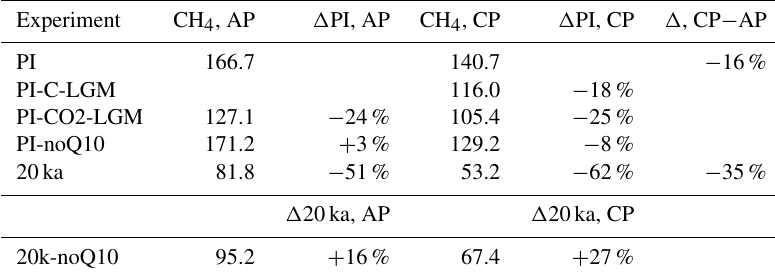
Table A1. Sensitivity experiment results: wetland CH 4 emissions (TgCH 4 yr − 1 ) on all grid points (AP), emission change (%) with regard to PI state on all points, wetland emissions (TgCH 4 yr − 1 ) on the common grid points (CP), emission change (%) with regard to PI state on the common points, and emission change between common points and all points (%). The reference state for emission change in experiment 20k-noQ10 is the 20ka state.